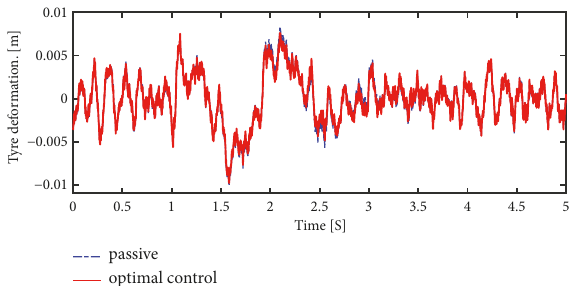
Figure 21: Time history response of tyre